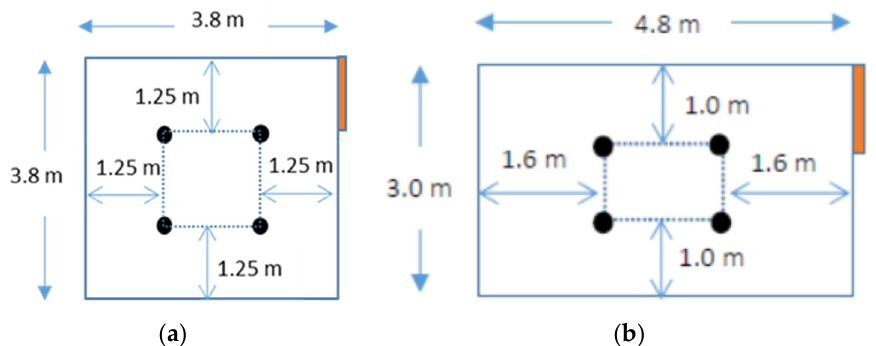
Figure 4. The measured positions of temperature at 0.1 m height from the ceiling. ( a ) square room, ( b ) rectangular room.